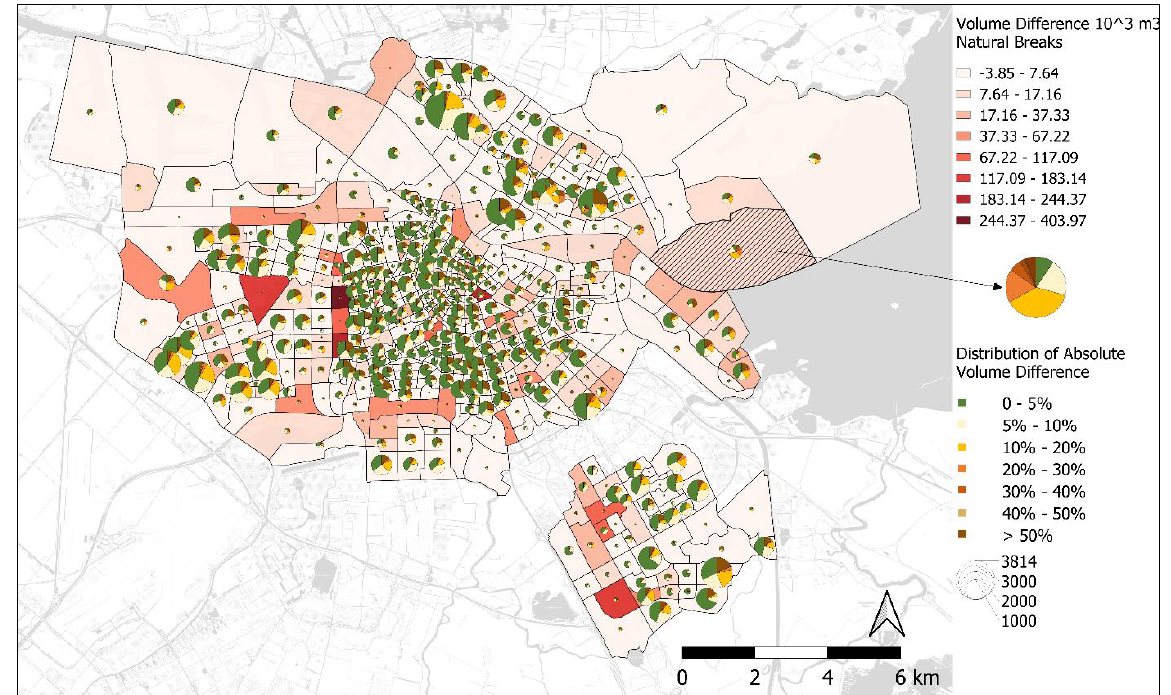
Figure 12. Distribution of volume differences between LoD22 and nDSM aggregated at neighbourhood